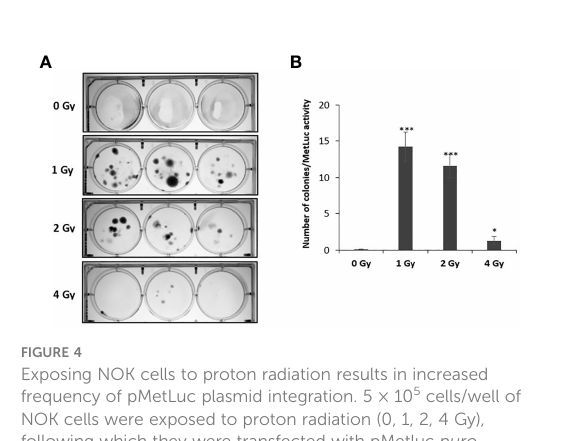
FIGURE 4 Exposing NOK cells to proton radiation results in increased frequency of pMetLuc plasmid integration. 5 × 10 5 cells/well of NOK cells were exposed to proton radiation (0, 1, 2, 4 Gy), following which they were transfected with pMetluc puro plasmid. To normalize for transfection ef fi ciency, the media was collected 48 hr post-transfection, and the expression of secreted luciferase was measured. Selection of cells resistant to puromycin (5 m g/ml) was performed daily for 2-3 weeks, following which the colonies produced were stained with crystal violet (A) , and normalized for transfection ef fi ciency (B) . (*), and (***) correspond to p < 0.05, and 0.001,